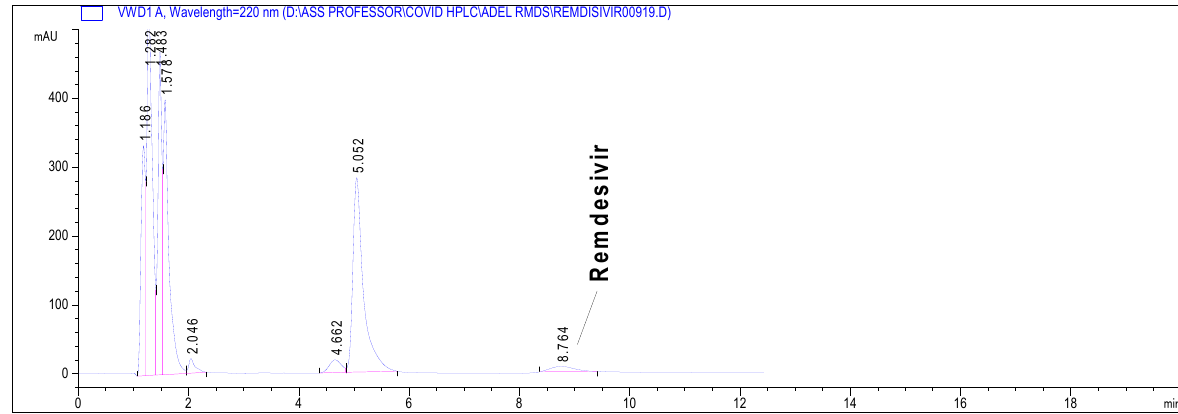
Figure 3. Chromatogram presenting stress degradation results of RDS in 0.1 N NqOH, 25 ◦ C/0.5 h under the proposed chromatographic